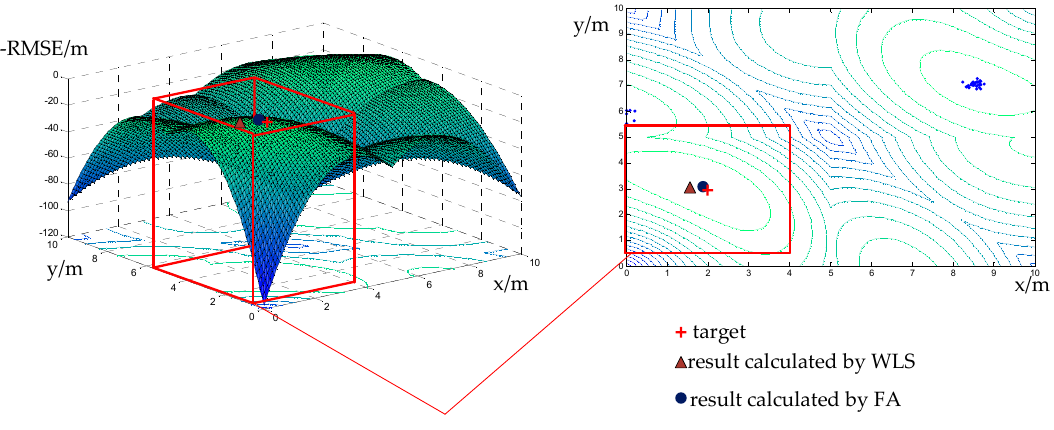
Figure 4. The diagram of hybrid-FA and FA.